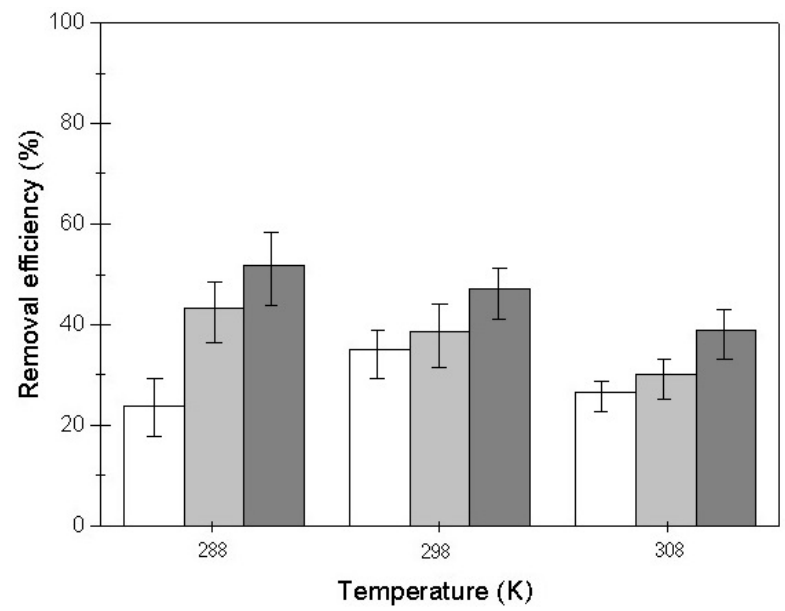
Figure 6. Removal e ffi ciency of COD present in cold meat industry wastewater employing 2 mA cm − 2 Figure 6. Removal efficiency of COD present in cold meat industry wastewater employing 2 mA cm − 2 and di ff erent temperatures. The initial pH values were 5 ( (cid:3) ), 7 ( (cid:4) ), and 9 ( (cid:4) and different temperatures. The initial pH values were 5 ( (cid:0) ), 7 (